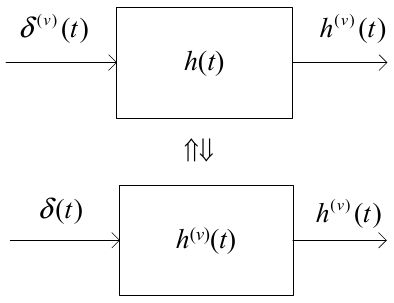
Figure 2. A fractional system resulting from δ ( v ) ( t )